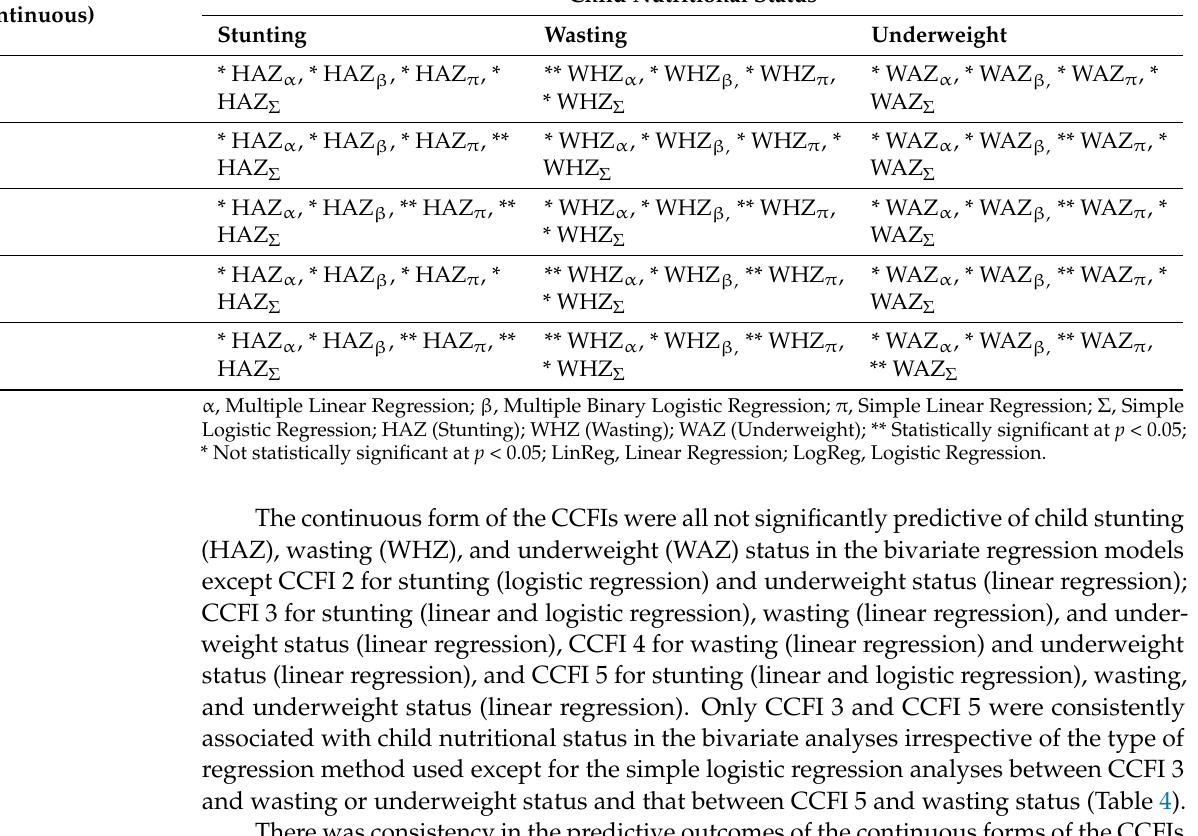
Table 4. Predictive utility of continuous forms of CCFIs for child nutritional status. Child Nutritional Status Wasting